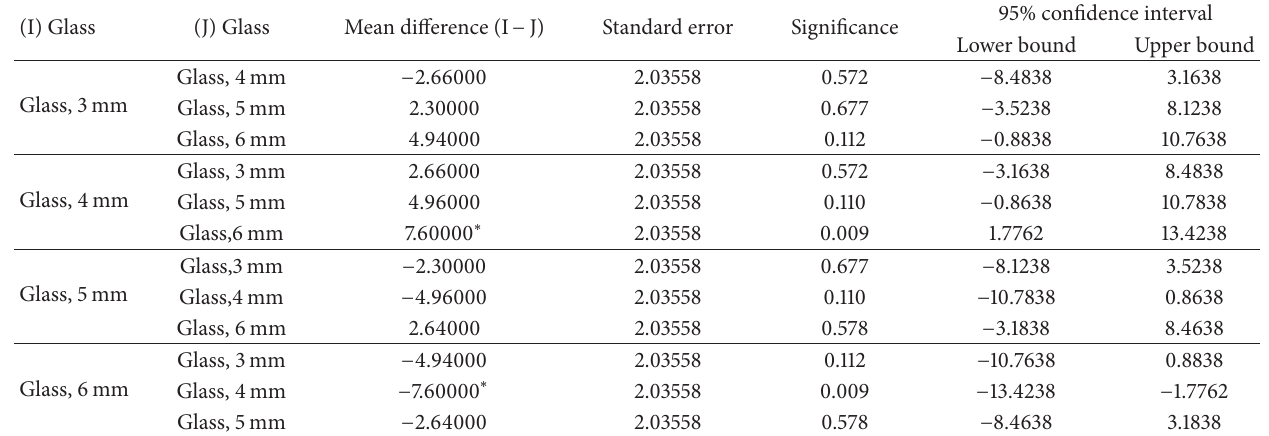
Table 5: Multiple comparisons test for collector mean